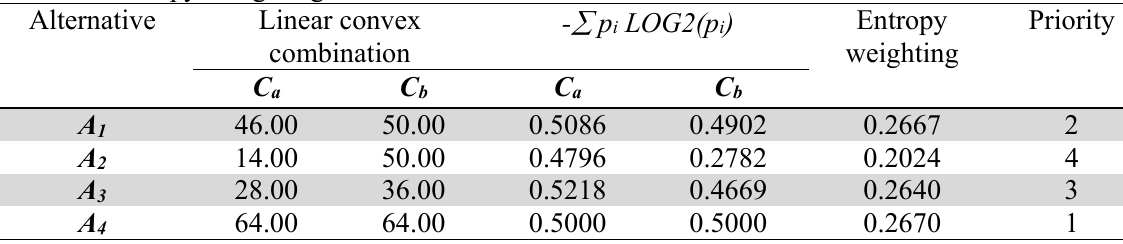
Moderate Entropy Weighting with  -level=0.50